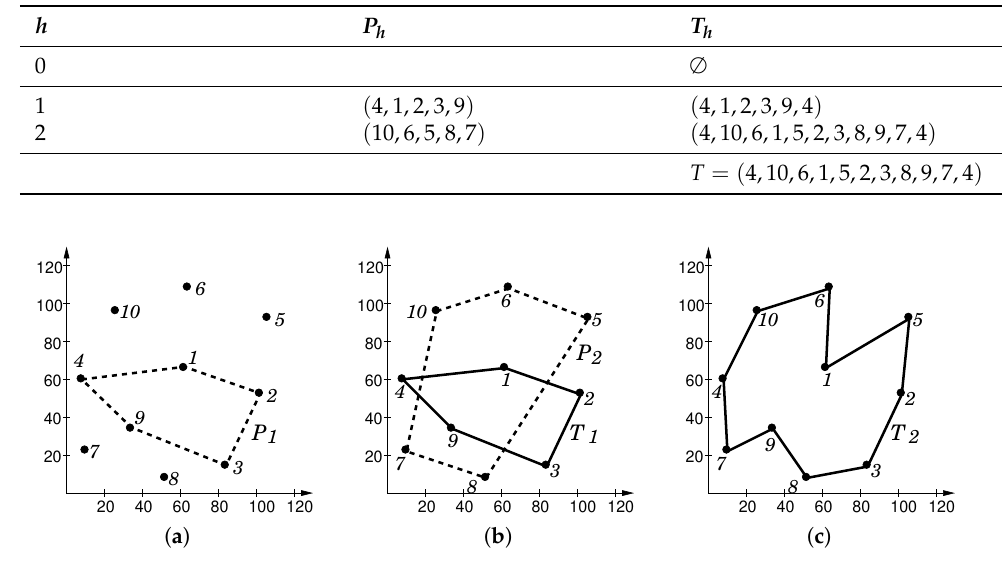
Figure 20. Inflammation algorithm flowchart. Table 4 and Figure 21 illustrate Algorithm 3 for problem instance “tsp10” with 10 ver- tices. In Figure 21a, inner convex polygon P 1 = ( 4, 1, 2, 3, 9 ) is constructed, considering the vertices of V \ T 0 = V . In Figure 21b, T 1 = ( 4, 1, 2, 3, 9, 4 ) is constructed with the vertices included in P 1 and P 2 = ( 7, 10, 6, 5, 8 ) is constructed with the vertices included in V \ T 1 . In Figure 21c, T 2 = ( 4, 10, 6, 1, 5, 2, 3, 8, 9, 7, 4 ) is constructed by inserting the vertices from P 2 in tour T 1 . The resultant feasible solution T = T 2 . Table 4. Iterations performed by Algorithm 3 ( INFLAMMATION ) for the construction of tour T for example instance “tsp10”.